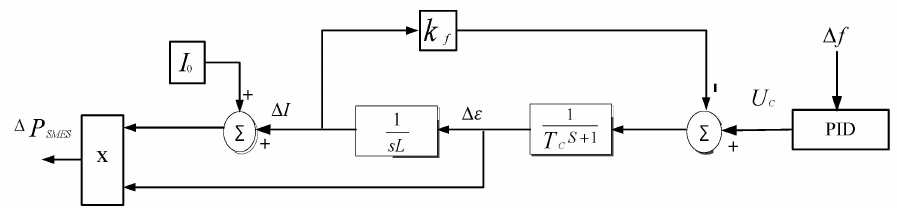
Figure 7. Block diagram of